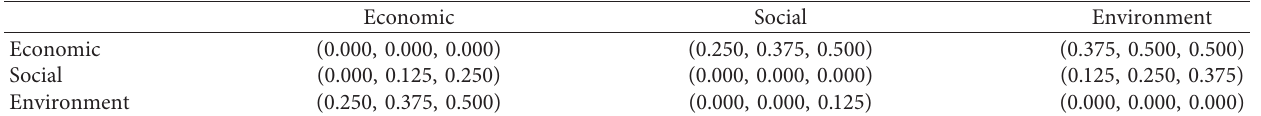
Table 35: Normalized matrix of sustainability dimensions in fuzzy condition.